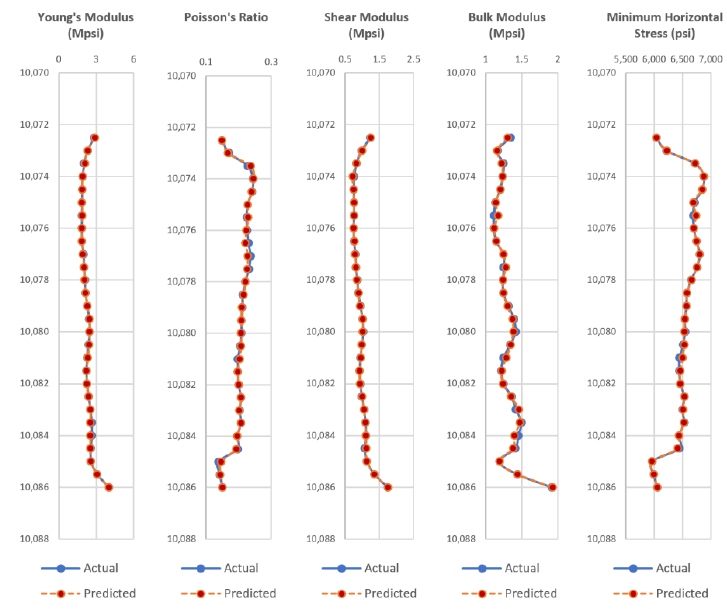
Figure A2. Actual and predicted geomechanical properties along with depth (feet) for test well 1 in Burke County for the Middle Bakken Formation.